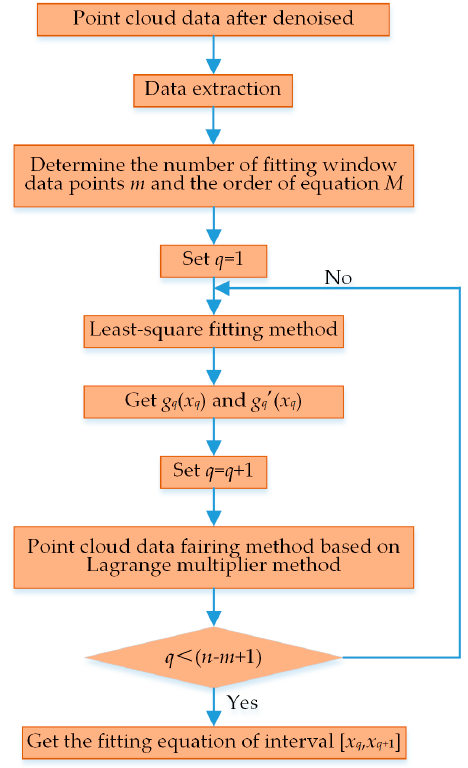
Figure 7. The flowchart of fairing processing for point cloud data.